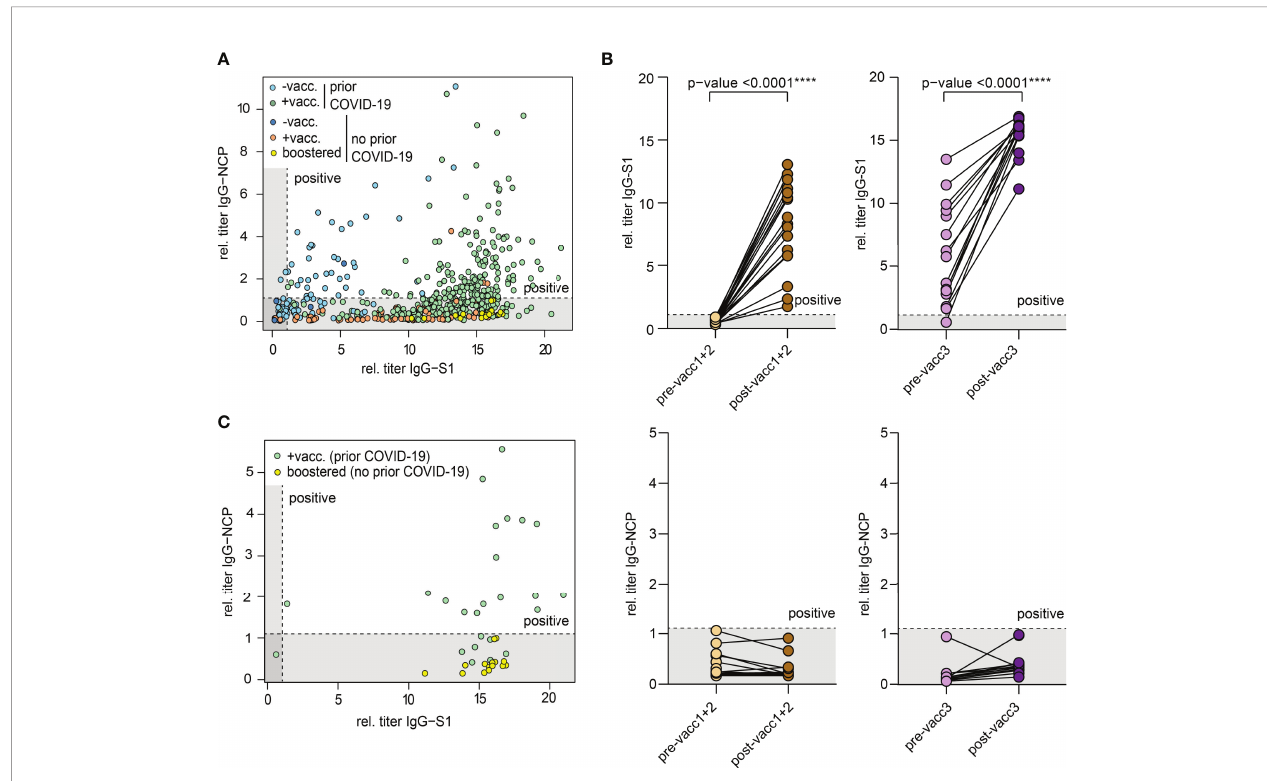
FIGURE 2 | Antibodies against the S1 domain of the spike (S) protein and the nucleocapsid protein (NCP) of SARS-CoV-2. (A) Comparison of IgG-NCP and IgG-S1 antibodies in vaccinated individuals with or without prior COVID-19 infection. (B) Matched IgG-S1 and IgG-NCP antibody titers of previously uninfected individuals prior to and after the primary vaccination series (pre-/post-vacc1+2) and the third vaccination (pre-/post-vacc3). Statistical test: Two-tailed paired t-test. p-value cut-offs: <0.0001 extremely signi fi cant (****). (C) Comparison of IgG-NCP and IgG-S1 antibodies between previously infected participants that received a subsequent vaccination (green) and previously uninfected participants with three vaccinations (yellow). Both types of blood samples were collected at a maximum of 4 weeks from last vaccination. Cut- off values are presented as hatched